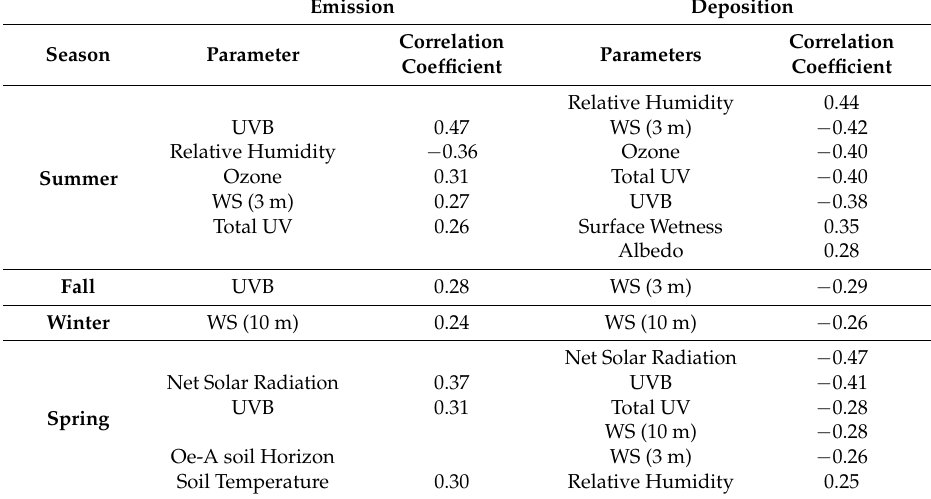
Table 4. The variables most highly correlated with GEM emission and deposition. Only those variables with a correlation coefficient (r) greater than 0.25 are reported unless no variables were above 0.25 then only the variable with the highest r -value is